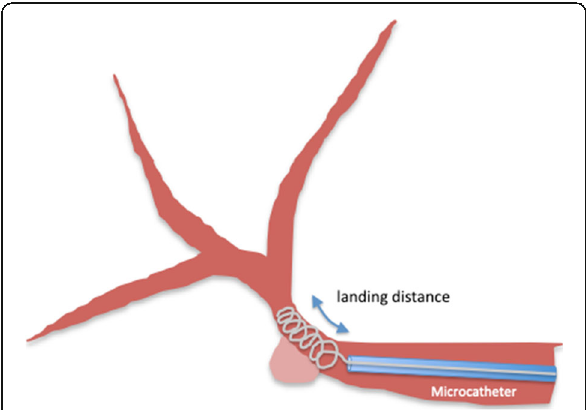
Fig. 1 The distance between the distal end of the first penumbra occlusion device and the microcatheter tip was defined as the “ landing distance, ” and this was evaluated via fluoroscopic